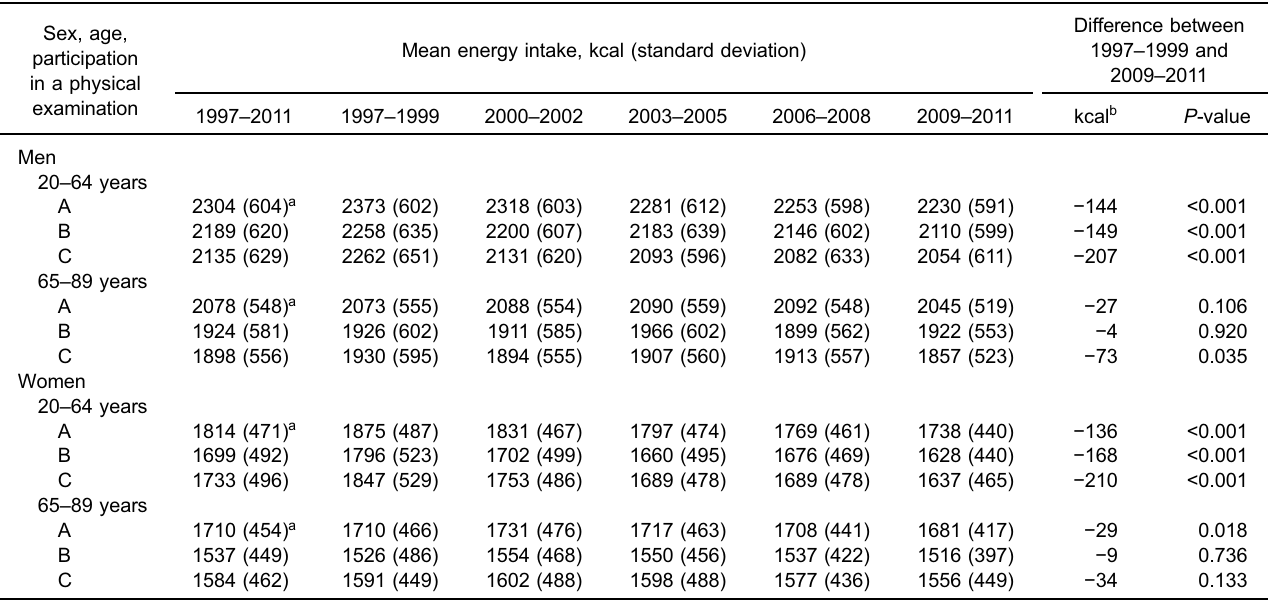
Table 2. Mean energy intake of study subjects by status of participation in a physical examination, sex, age group, and 3-year survey period Sex, age,